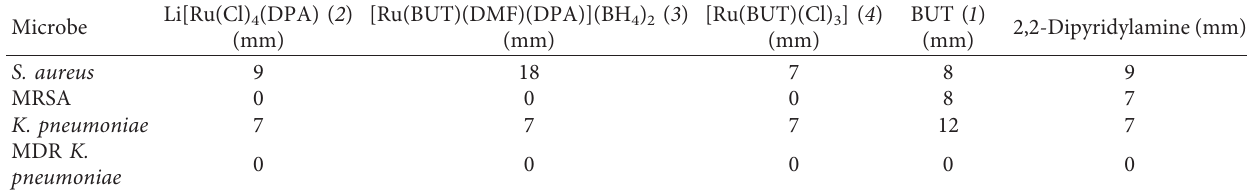
Table 4: Average zones of inhibition of all